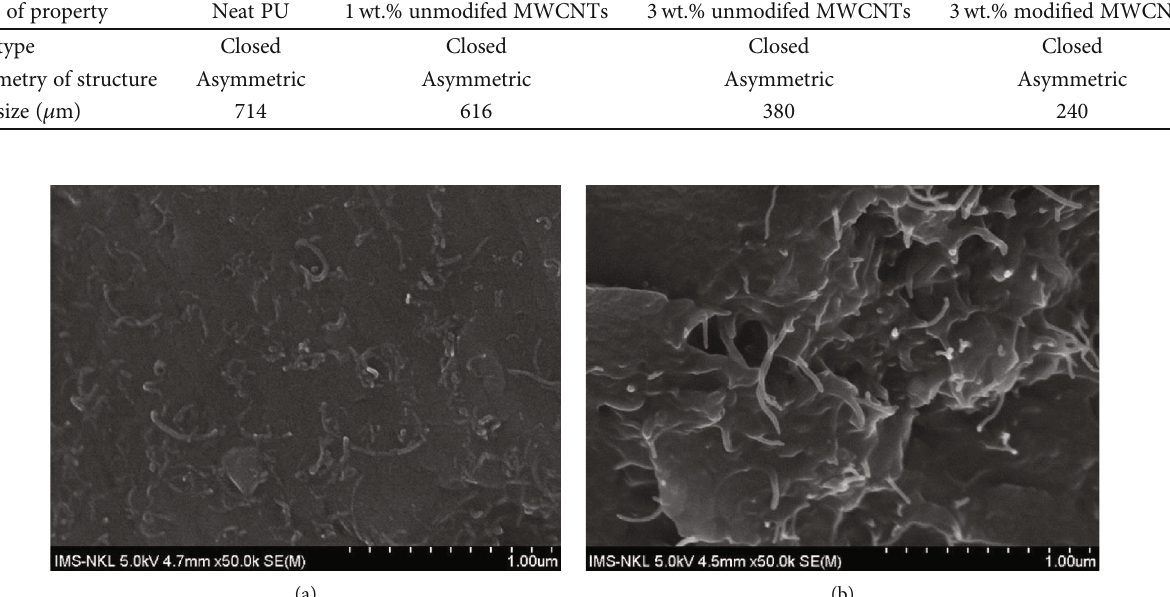
Figure 6: High magni fi cation SEM micrograph of foam containing (a) 3 wt.% MWCNTs and (b) 3 wt.% modi fi ed